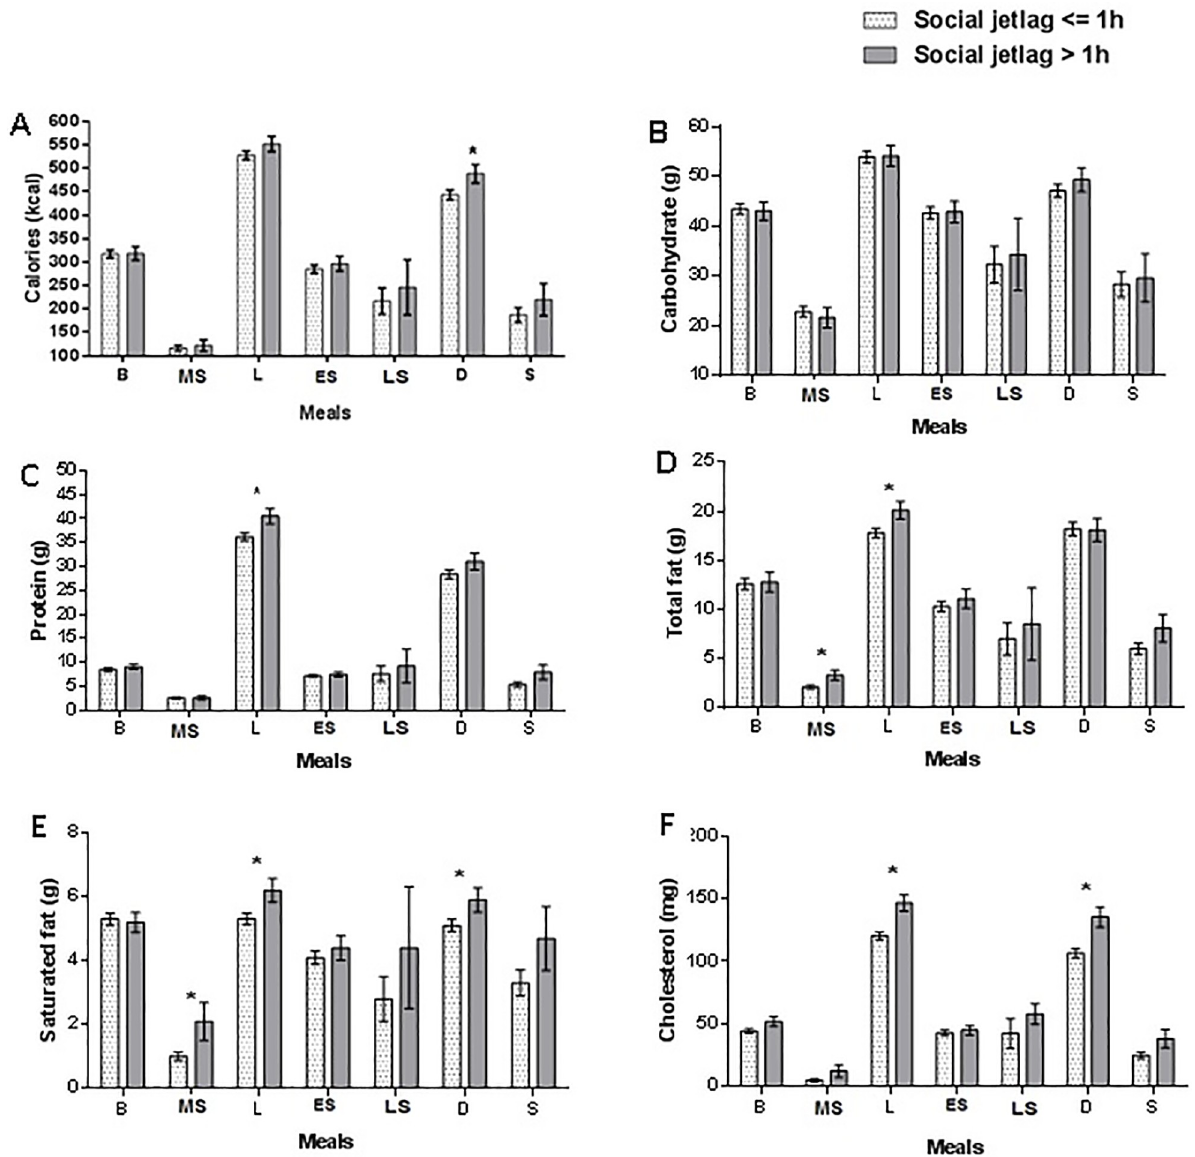
Fig 1. Association of social jetlag on distribution of calories and macronutrients at each meal or snack along of the day. Note: A. Calories (kcal): group with social jetlag had a higher calorie (kcal) intake at dinner (443.4 ± 10.5 vs. 488.4 ± 19.8; p = 0.03). B. Carbohydrate (g): no association of social jetlag. C. Protein (g): group with social jetlag had a higher protein (g) intake at lunch (36.2 ± 0.80 vs 40.5 ± 1.60; p = 0.01). D. Total fat (g): group with social jetlag had a higher total fat intake (g) in the morning snack (p = 0.02) and lunch (p = 0.03). E. Saturated fat (g): group with social jetlag had a higher saturated (g) fat intake in the morning snack (1,0g ± 0.13 vs. 2.1g ± 0.59; p = 0.02); lunch (5.3g ± 0.18 vs. 6.2g ± 0.37;p = 0.03) and dinner (5.1g ± 0.19 vs. 5.9g ± 0.38; p = 0.03). F. Cholesterol (mg) group with social jetlag had a higher cholesterol intake (mg) at lunch (120.4 ± 3.1 vs. 146.5 ± 6.6 p < 0.001) and dinner (106.5 ± 3.7 vs. 135.3 ± 8.0; p < 0.001). � GzLM analyses were adjusted for age, sex, BMI, minutes of physical activity per week and mean sleeping duration. Values are presented as mean and standard error (SE).Total individuals who reported performing each of